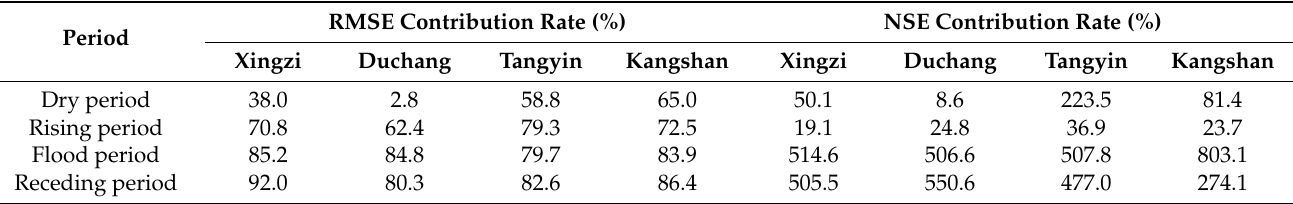
Table 5. Contribution of the Yangtze River on RMSE and